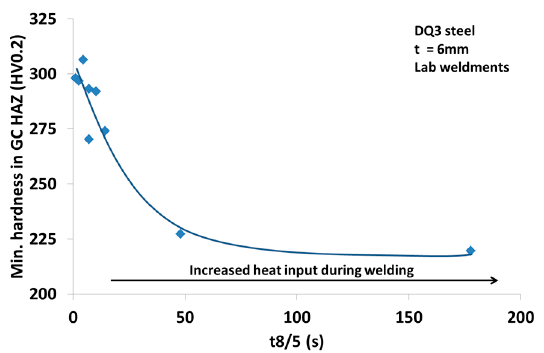
Figure 8. Minimum hardness measured in the GC HAZ for lab welds of DQ3 with different heat inputs ( t 8/5 = cooling time from 800 to 500 °C).